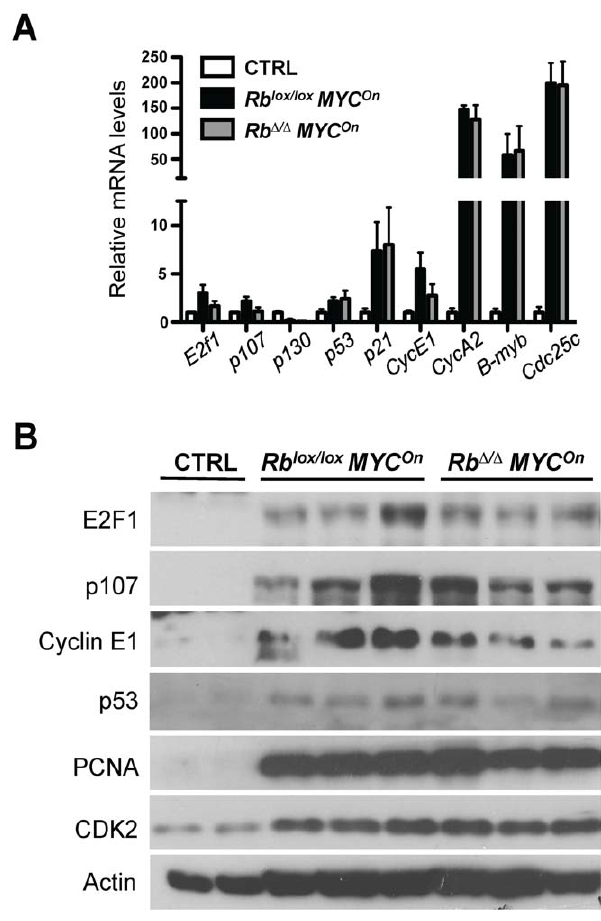
Figure 4. Rb inactivation does not change the mRNA expres- sion or protein levels of cell cycle markers in MYC-induced HCC. A. RT-qPCR for several cell cycle genes on RNA from MYC (black, n=3) and MYC/Rb (grey, n=3) mutant HCC. Rb lox/lox MYC Off non-tumor liver is used as a control (CTRL) (white, n=2). There is not statistical difference for any of these gene expression levels between MYC and MYC/Rb tumors. B. Representative immunoblot analysis for several cell cycle markers on protein extracts from MYC and MYC/Rb mutant HCC compared to wild-type liver. The concentration of the protein extracts was quantified using a Bradford assay and similar amounts of proteins were loaded in each lane. Actin serves as a loading control; note that CTRL liver cells express less Actin per m g of protein extract than tumor cells.